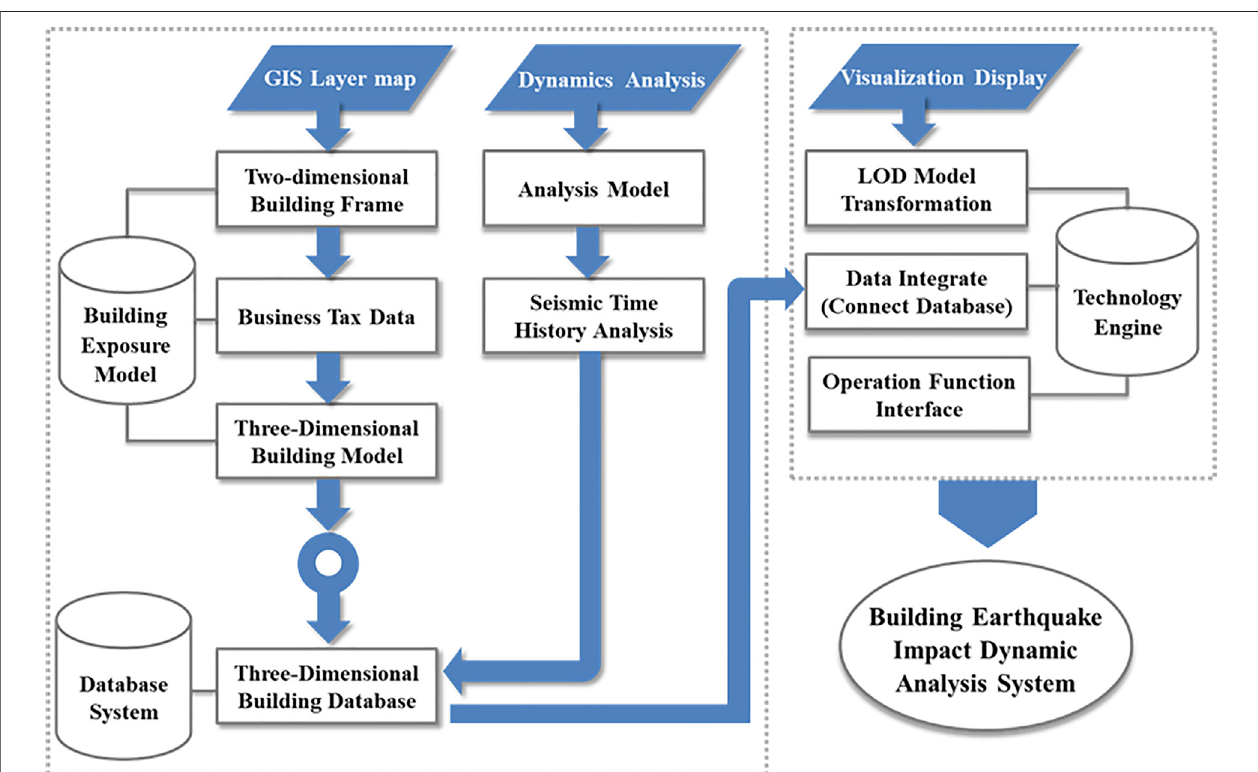
FIGURE 7 | Construction of a dynamic analysis system for investigating the impact of earthquakes on buildings.